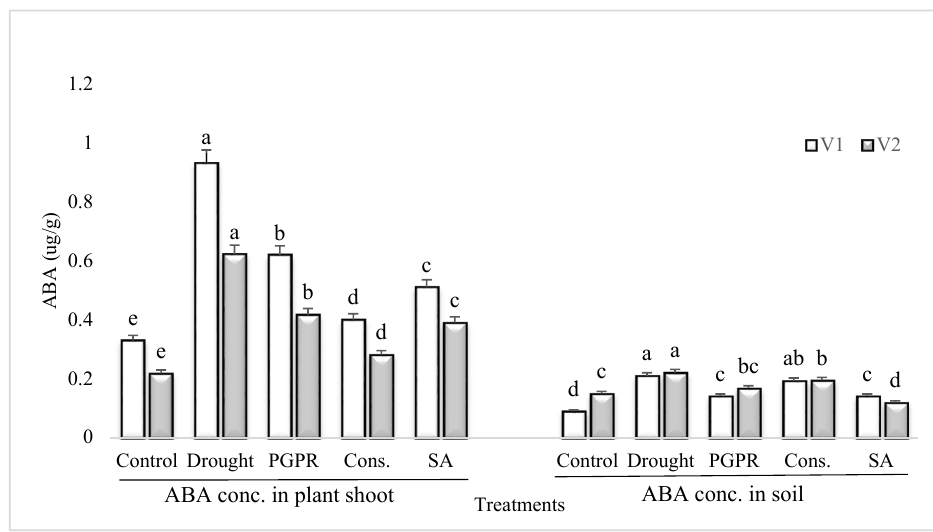
Figure 5. ABA content in plant shoot and rhizosphere of drought sensitive and tolerant varieties grown under rainfed conditions. V1: drought sensitive variety; V2: drought tolerant variety. Different significance levels were denoted with different letters (a, b, c, d and e).